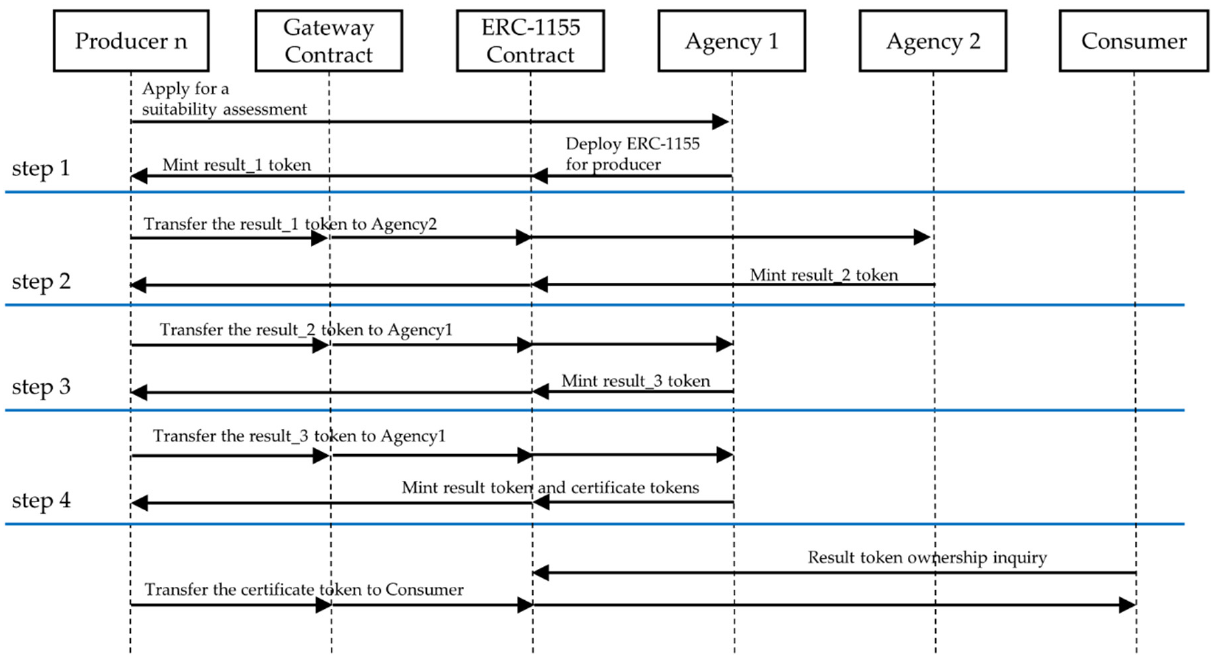
Figure 10. Blockchain-based wild-simulated ginseng quality management process sequence dia- gram.